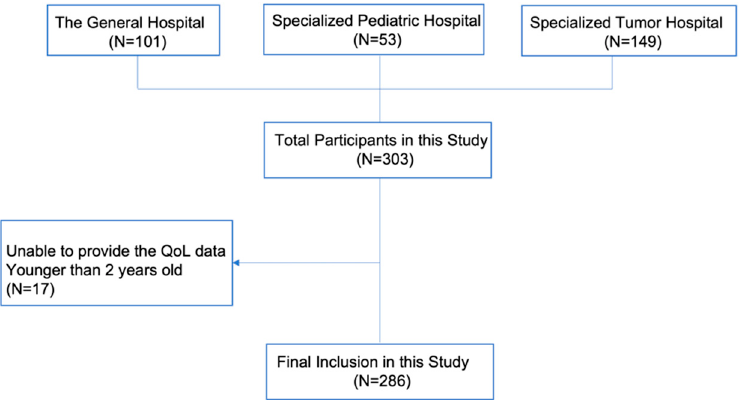
Figure 1. Study flowchart of participant selection .